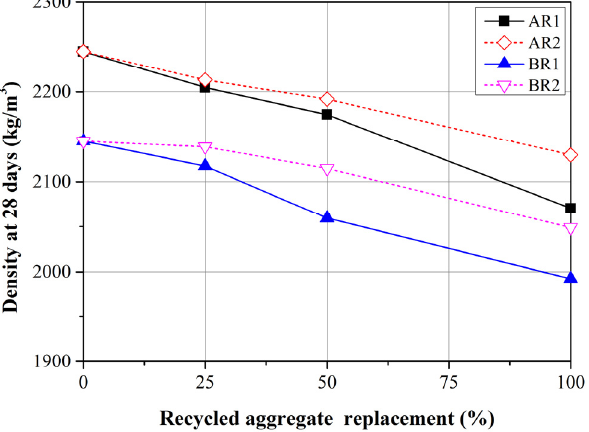
Figure 6. Density of mortars with R1 and R2 replacement at 28